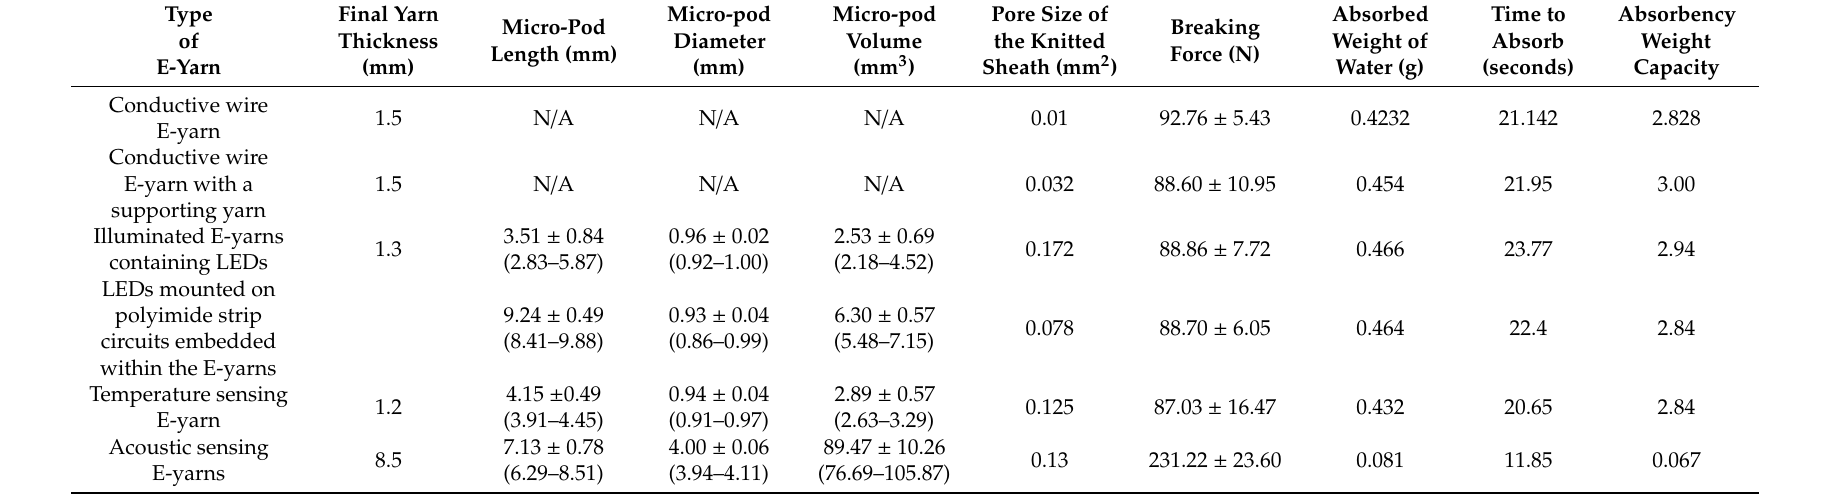
Table 1. Material properties of the E-yarns used in this